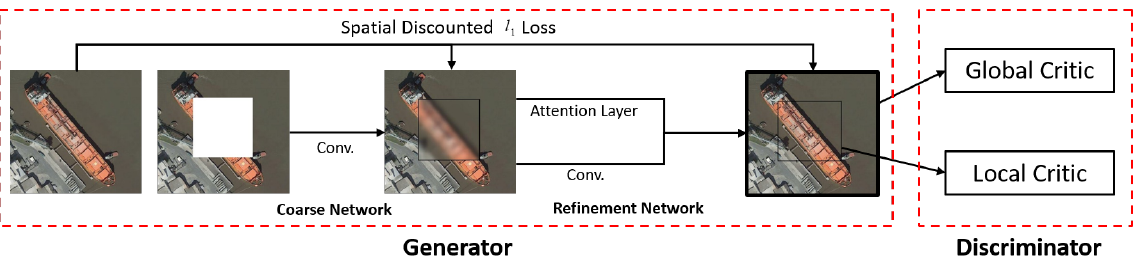
Figure 6. Image inpainting algorithm